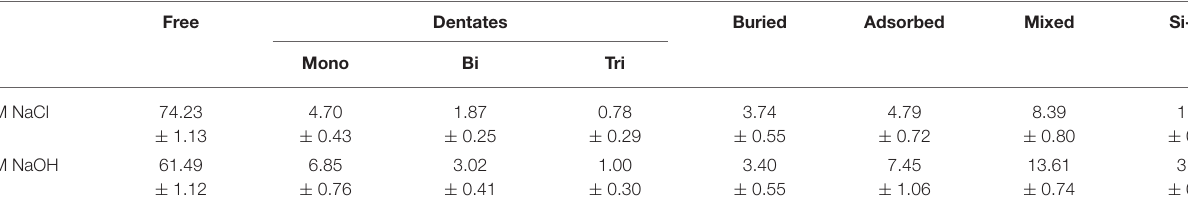
Free Dentates Buried